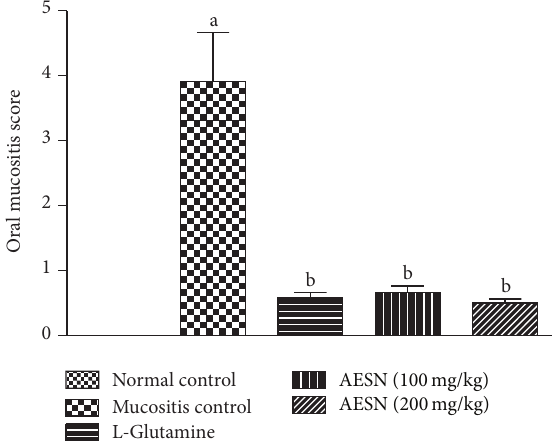
Figure 4: Oral mucositis score in busulfan and radiation induced oral mucositis. Oral mucositis score was measured on a scale of 0 to 5. Scores were analyzed using Kruskal-Wallis test followed by Dunn’s multiple comparison tests. All values are expressed as mean ± SEM of 6 animals. a 𝑃 < 0.05 versus normal control, b 𝑃 < 0.05 versus mucositis